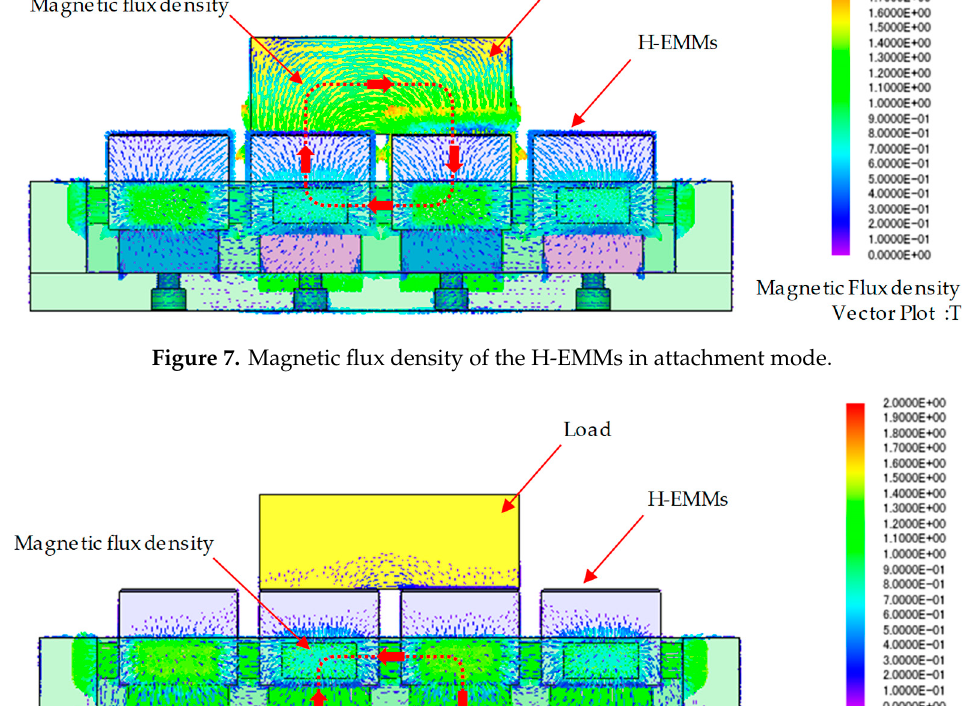
Figure 8. Magnetic flux density of the H-EMMs in detachment mode.